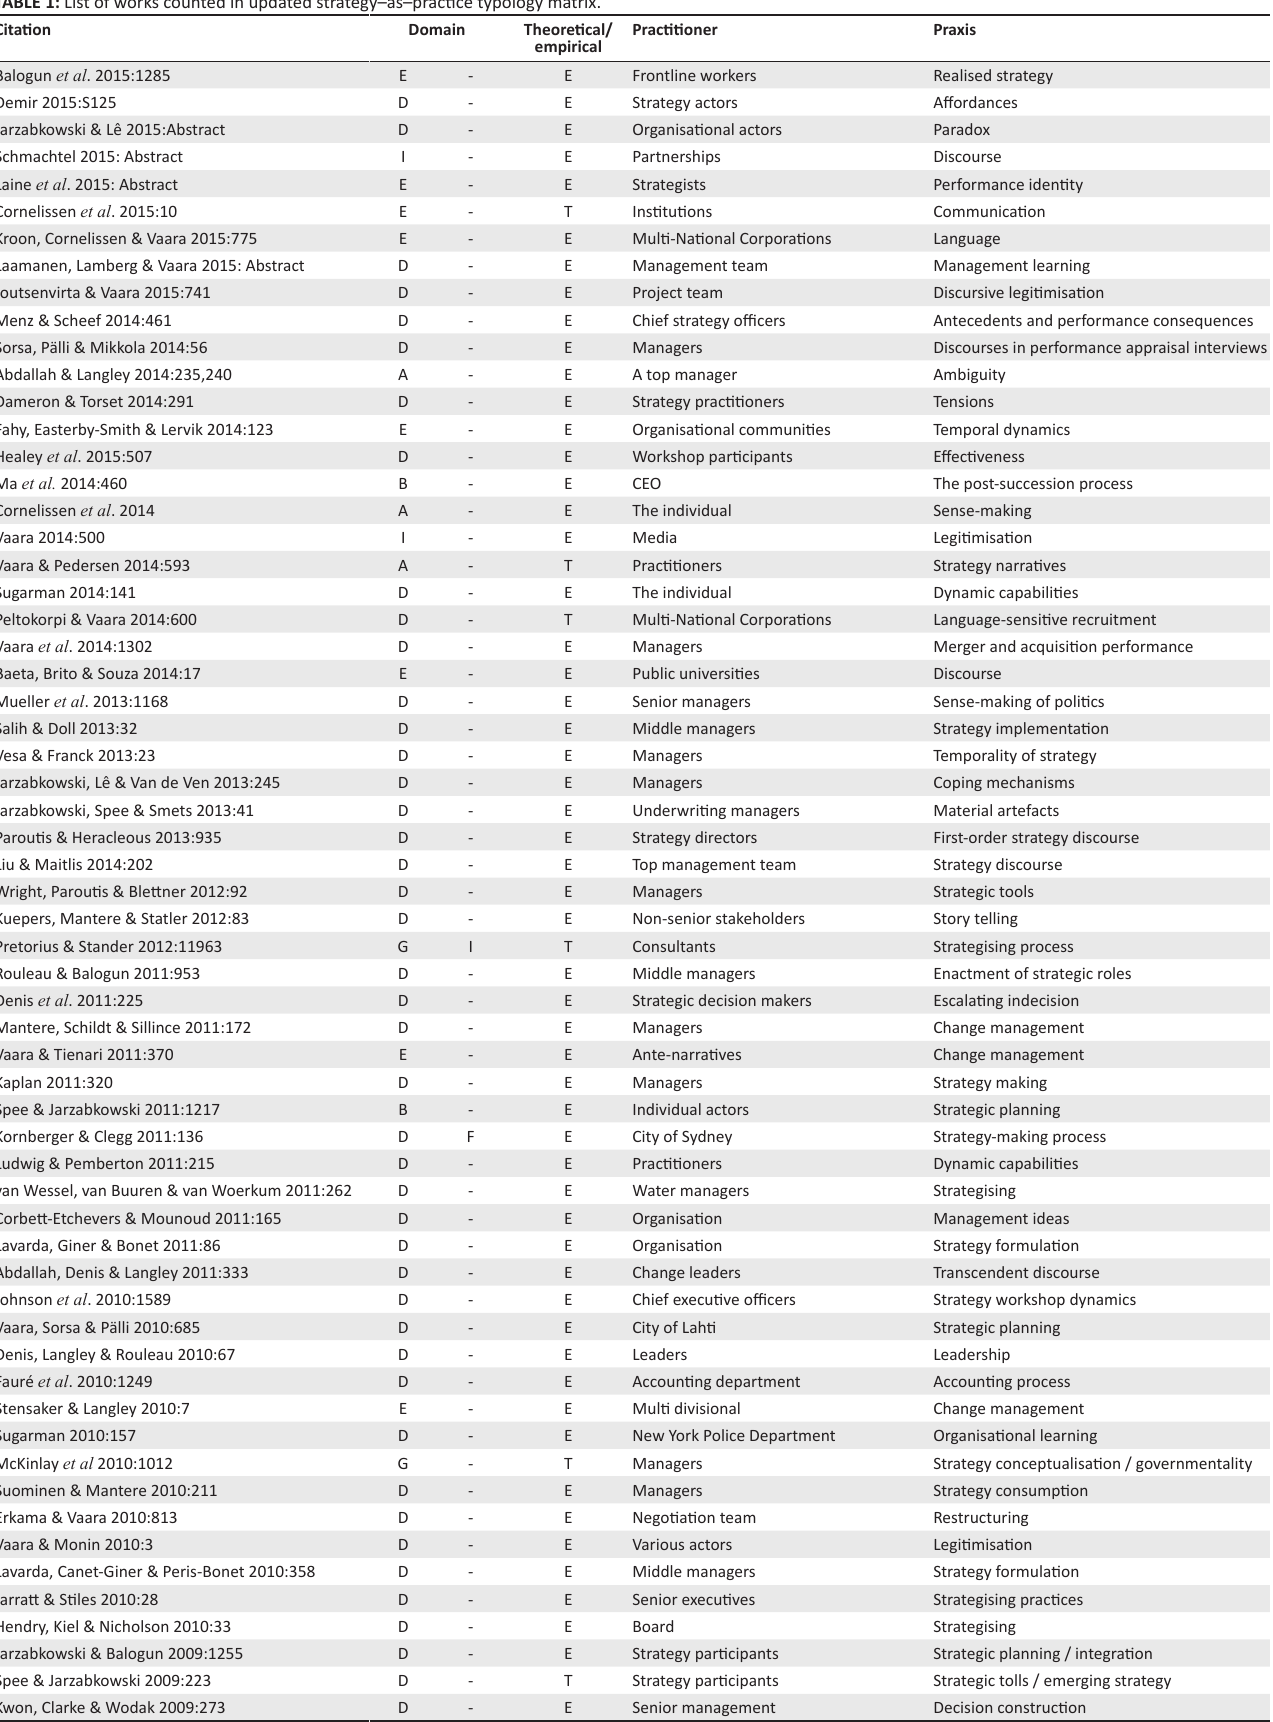
TABLE 1: List of works counted in updated strategy–as–practice typology matrix.